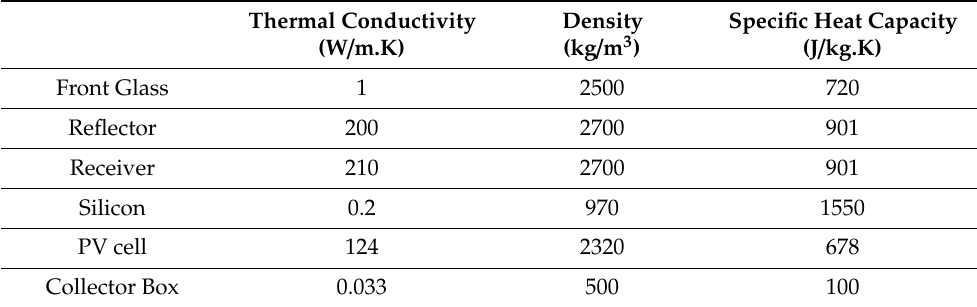
Table 3. Properties of di ff erent